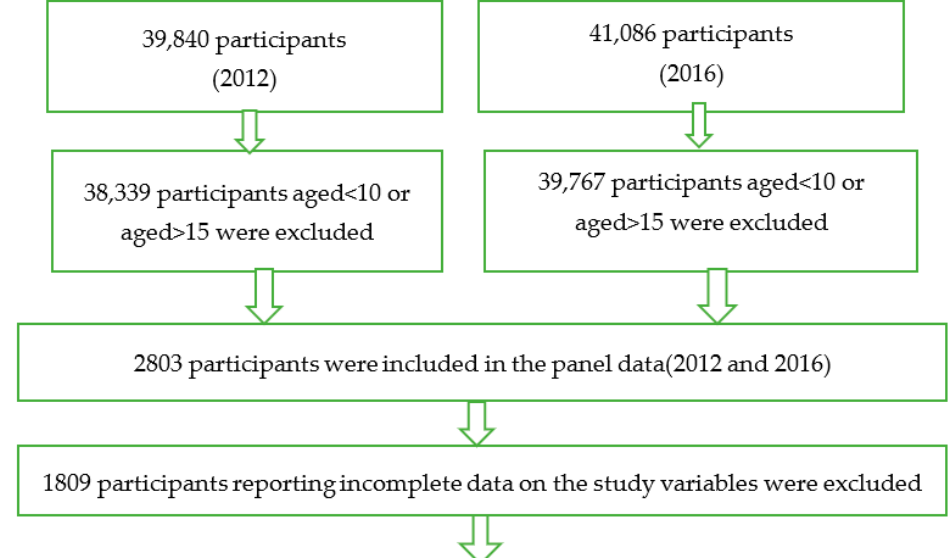
Figure 1. A flow chart of the study sample from 2012 to 2016.